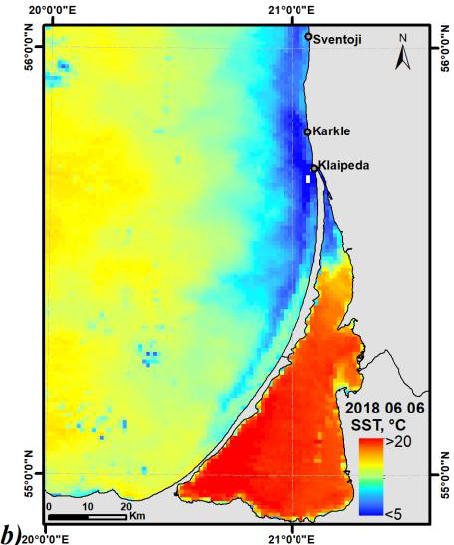
Figure 1. (a) Study area and sampling locations (marked as blue) at the coastal zone, which corresponds with the 20 m isobath. (b) An example of strong coastal upwelling in June 2018 on the Lithuanian Baltic coast, showing the spatial distribution of sea surface temperature from MODIS SST data.